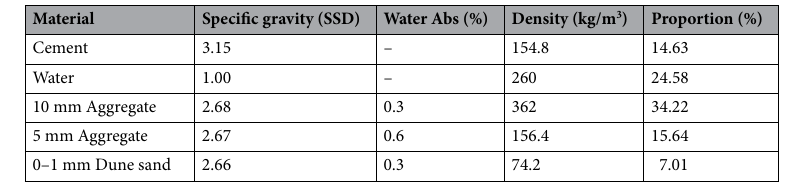
Table 2. Concrete mix design.